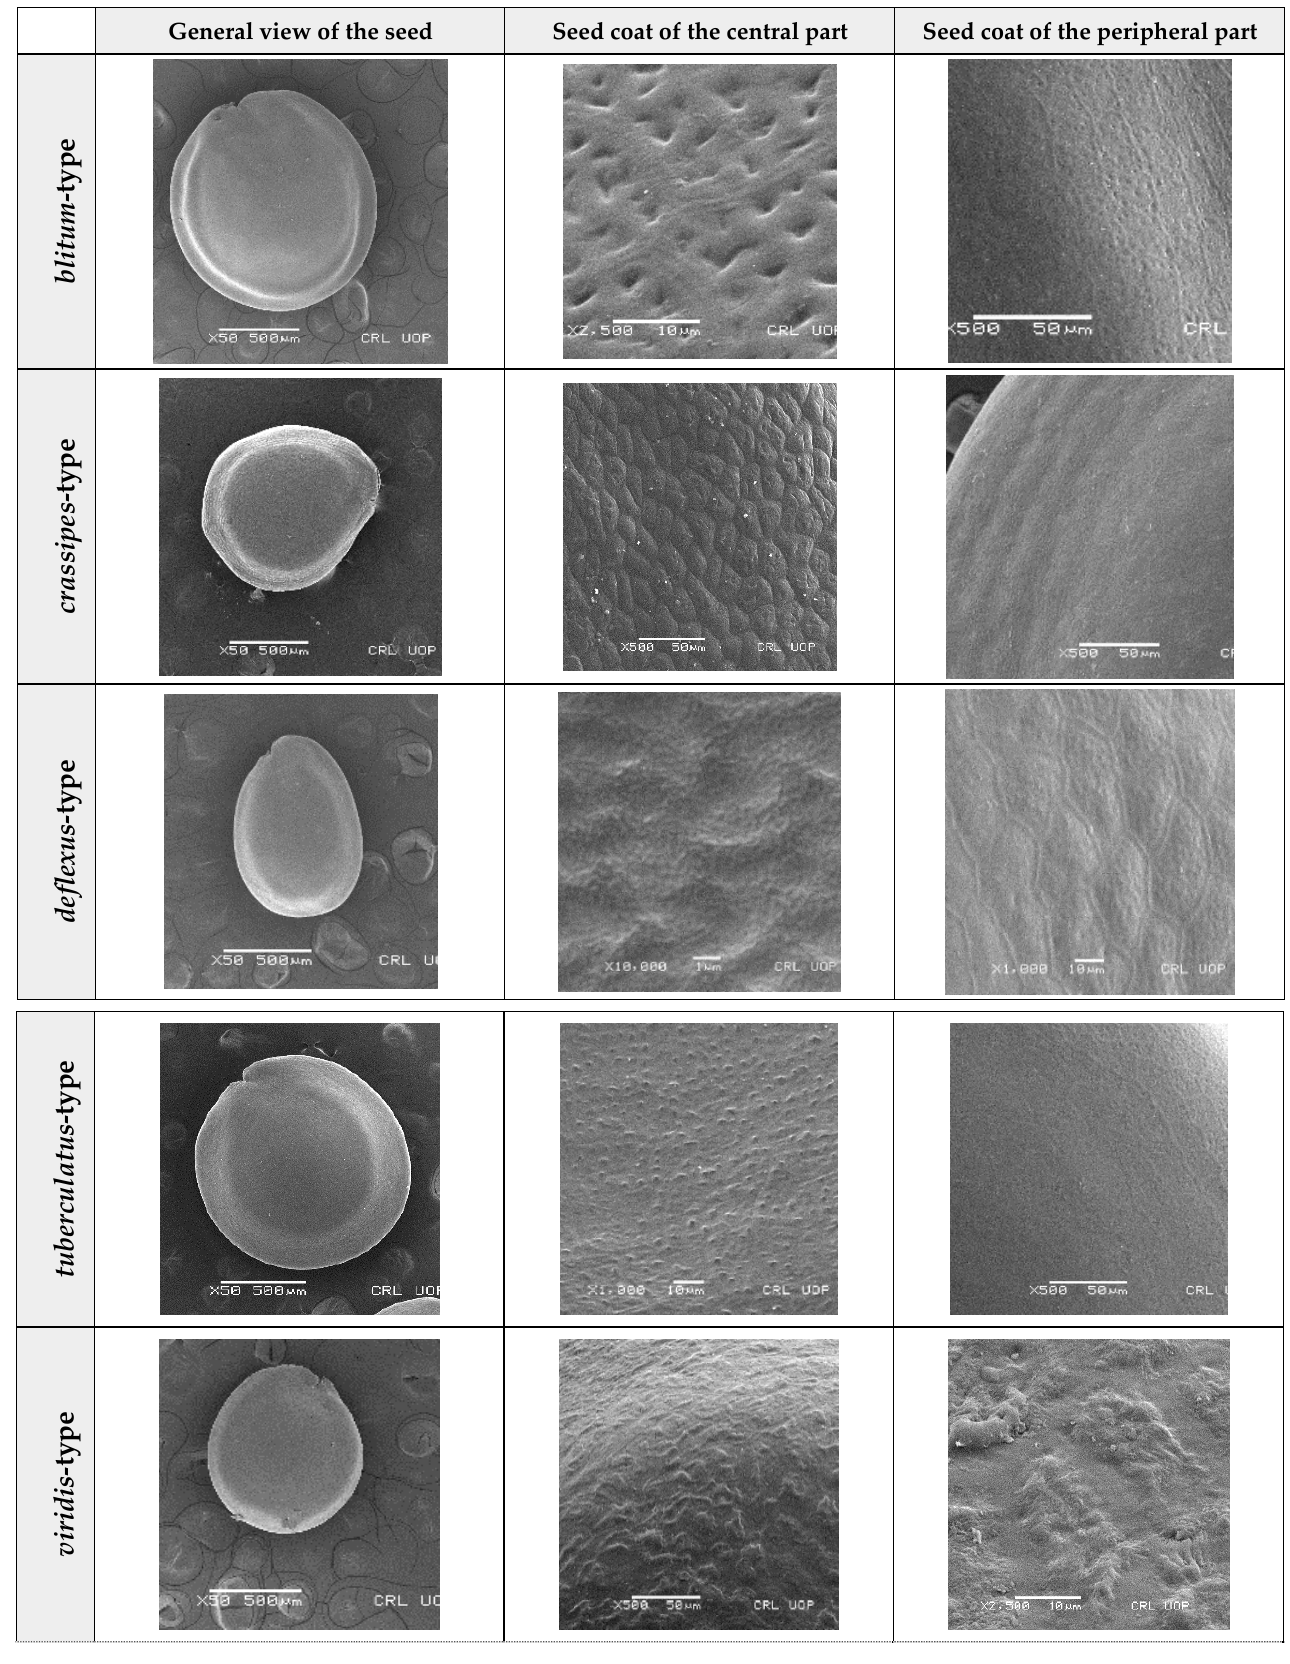
Figure 12. Types-pictures of the seed types defined.